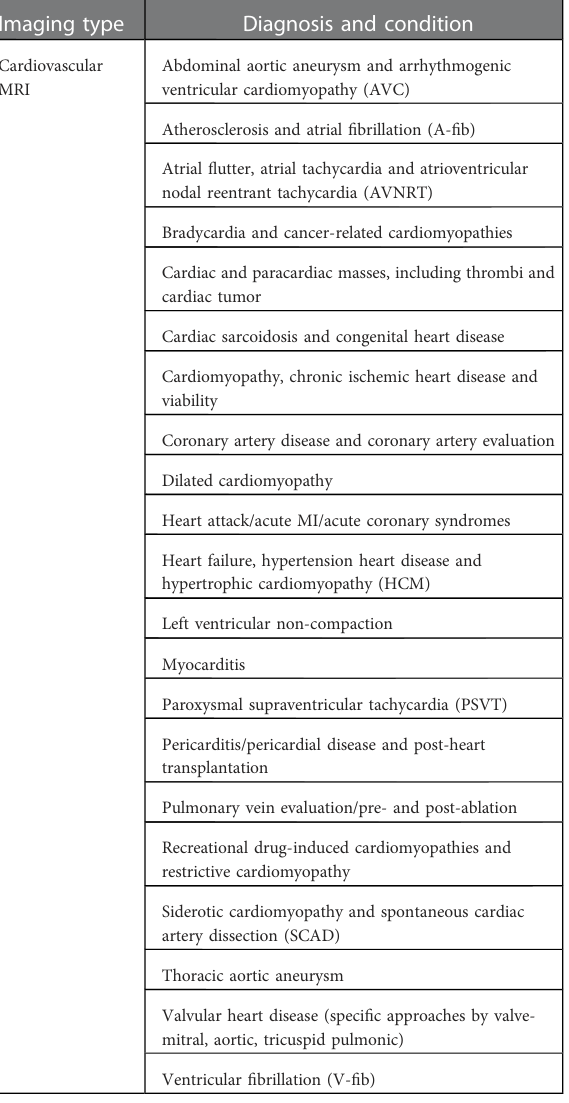
TABLE 3 Medical condition and diagnosis that can be identi fi ed by using cardiovascular MRI